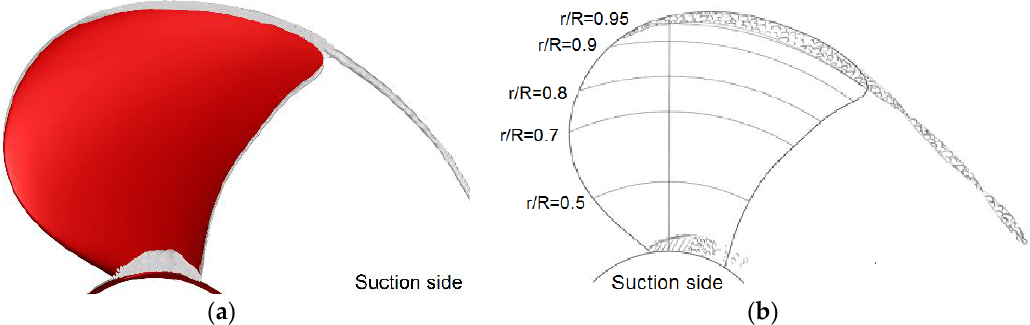
Figure 18. Comparison between the computed cavitation extension for σ n = 2.024 and the experimental cavitation sketch [46] reproduced with the permission of L. Lubke (SVA). ( a ): computation; ( b ): experiment.